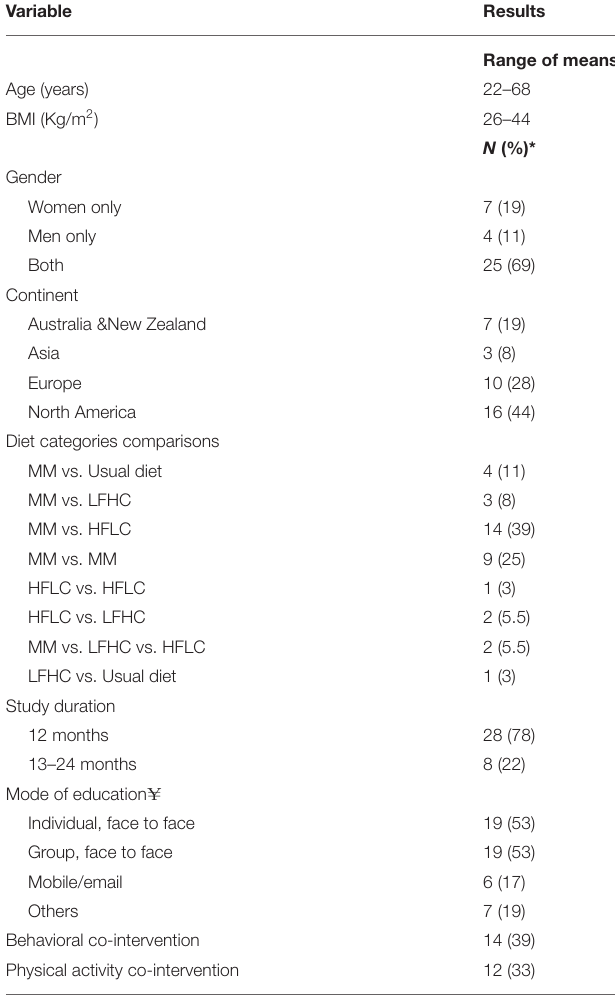
TABLE 1 | Summary of the population and intervention characteristics of the included randomized controlled trials (RCTs).